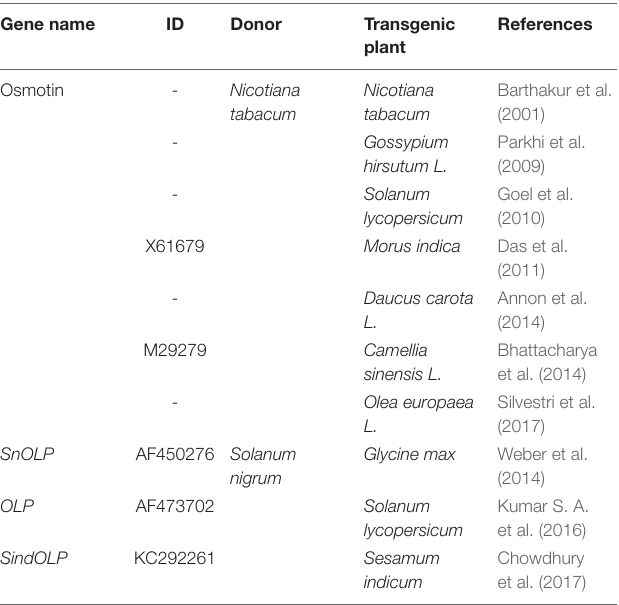
TABLE 1 | Transgenic plants overexpressing osmotins that confer drought